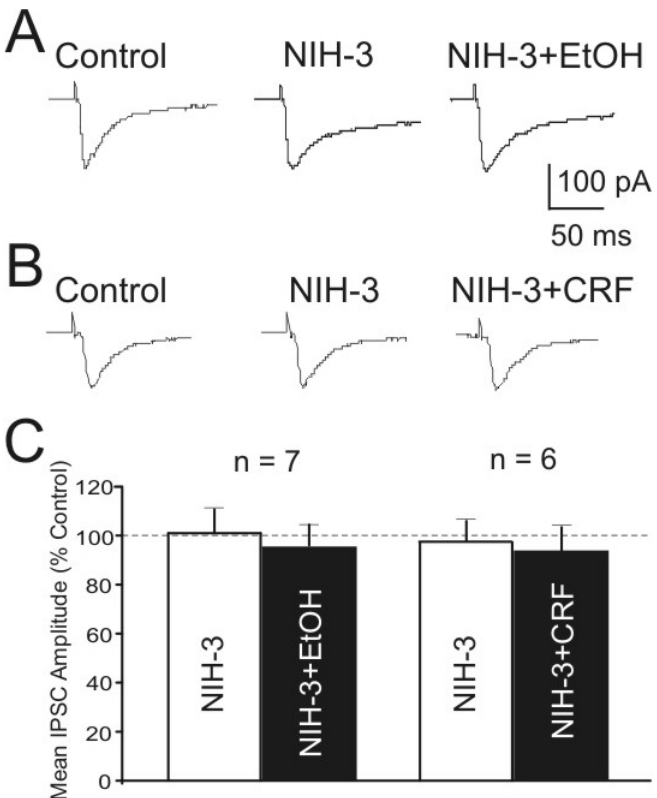
FIGURE 4. A selective CRF 1 antagonist blocks ethanol and CRF effects on evoked IPSCs in CeA neurons. (A) Representative current records of evoked IPSCs from a CeA neuron. Superfusion of the CRF 1 antagonist NIH-3 (10 µ M ) alone has little direct effect on the IPSCs, but blocks the usual ethanol (A; 44 m M ) and CRF (B; 100 n M ) augmentation of evoked IPSCs in this CeA neuron from a WT mouse. (B) Pooled data of the effect of NIH-3 with ethanol or CRF on GABA A IPSCs in CeA neurons from WT mice (n = 5). NIH-3 (10 µ M ) had no direct effect on the mean evoked IPSC amplitude, but significantly prevented the usual ethanol and CRF effects on mean amplitudes (compare to Figs. 1 and